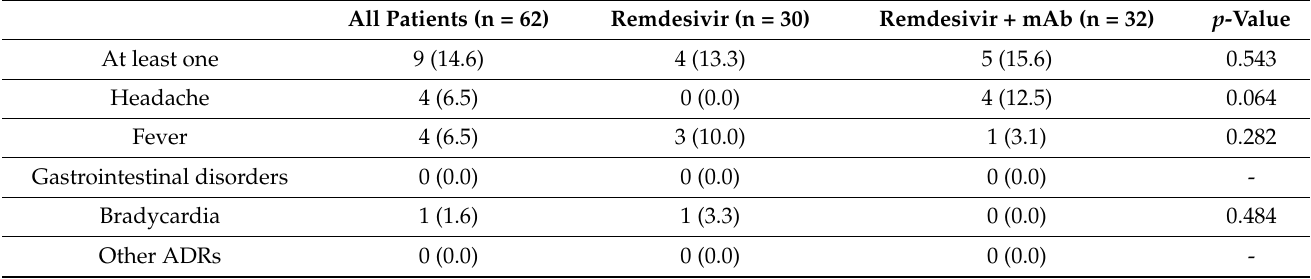
Table 3. ADRs recorded in the study population and differences between the two treatment